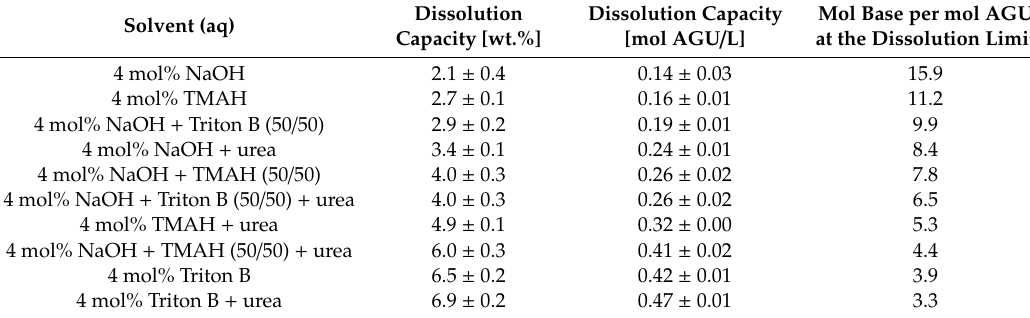
Table 1. The estimated maximum dissolution capacity of microcrystalline cellulose (MCC) in the di ff erent solvents given in weight% of the total weight of the solution and in mol MCC per L of solvent. Also given is the calculated mol base per mol AGU at the dissolution limit. The results are arranged in order of increasing dissolution